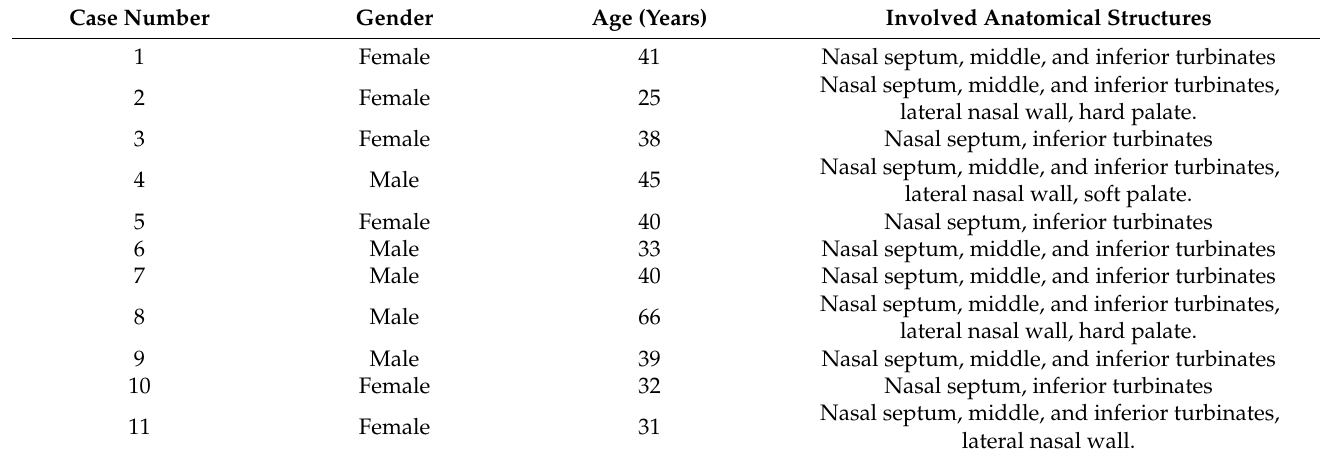
Table 1. Age, gender, and involved anatomical structures of the CIMDL patients included in the study. Case Number Gender Age (Years) Involved Anatomical